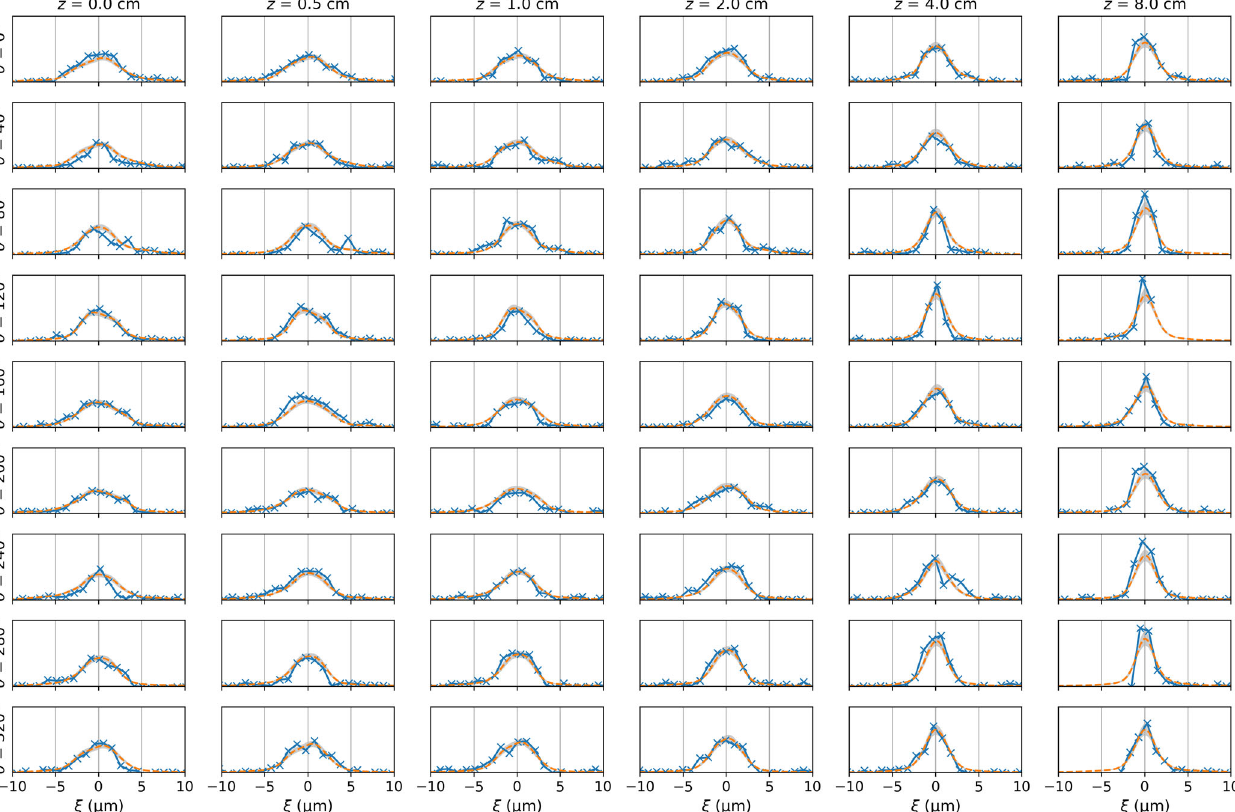
FIG. 5. Measured (blue crosses) and reconstructed (orange dashed) profiles of the electron beam distribution. The vertical axes are identical for all sub-plots and show the BLM signal or reconstruction in arbitrary units. Subplots in the same column correspond to the same z location of the wire scanner and subplots in the same row correspond to the same projection angle θ . The grey area depicts the uncertainty of the reconstruction. For the last column ( z ¼ 8 cm) the scan range did not cover the entire beam profile for all scans due to a misalignment of the electron propagation direction and the z -axis of the hexapod, which results in a transverse offset of the wire scanner device with respect to the electron beam. This effect is the largest for the last scan ( z ¼ 8 cm) since the wire scanner was aligned to the beam axis at z ¼ 0